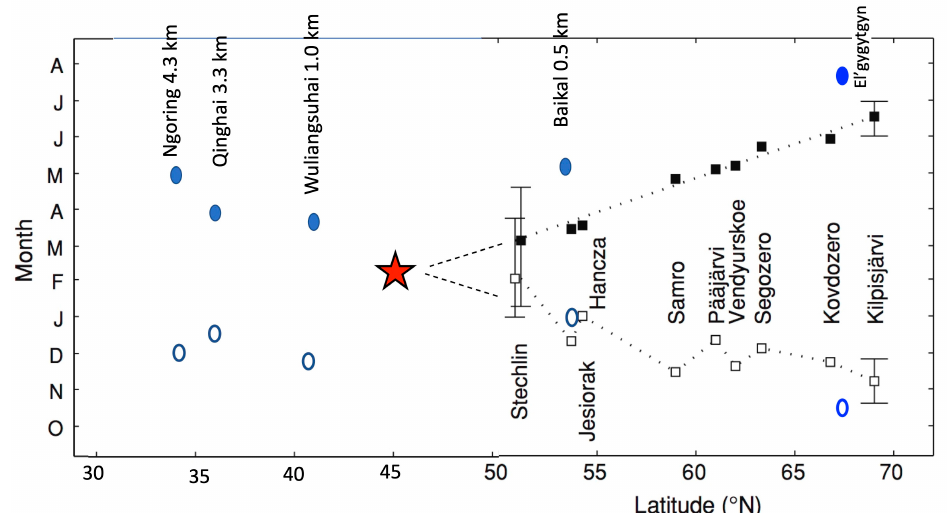
data points, but the eastward winter cooling effects are also included. The Lake Baikal breakup date fits in the picture but freezing date is quite late, because the large mixed-layer depth in Baikal delays the freezing date but does not affect the breakup.